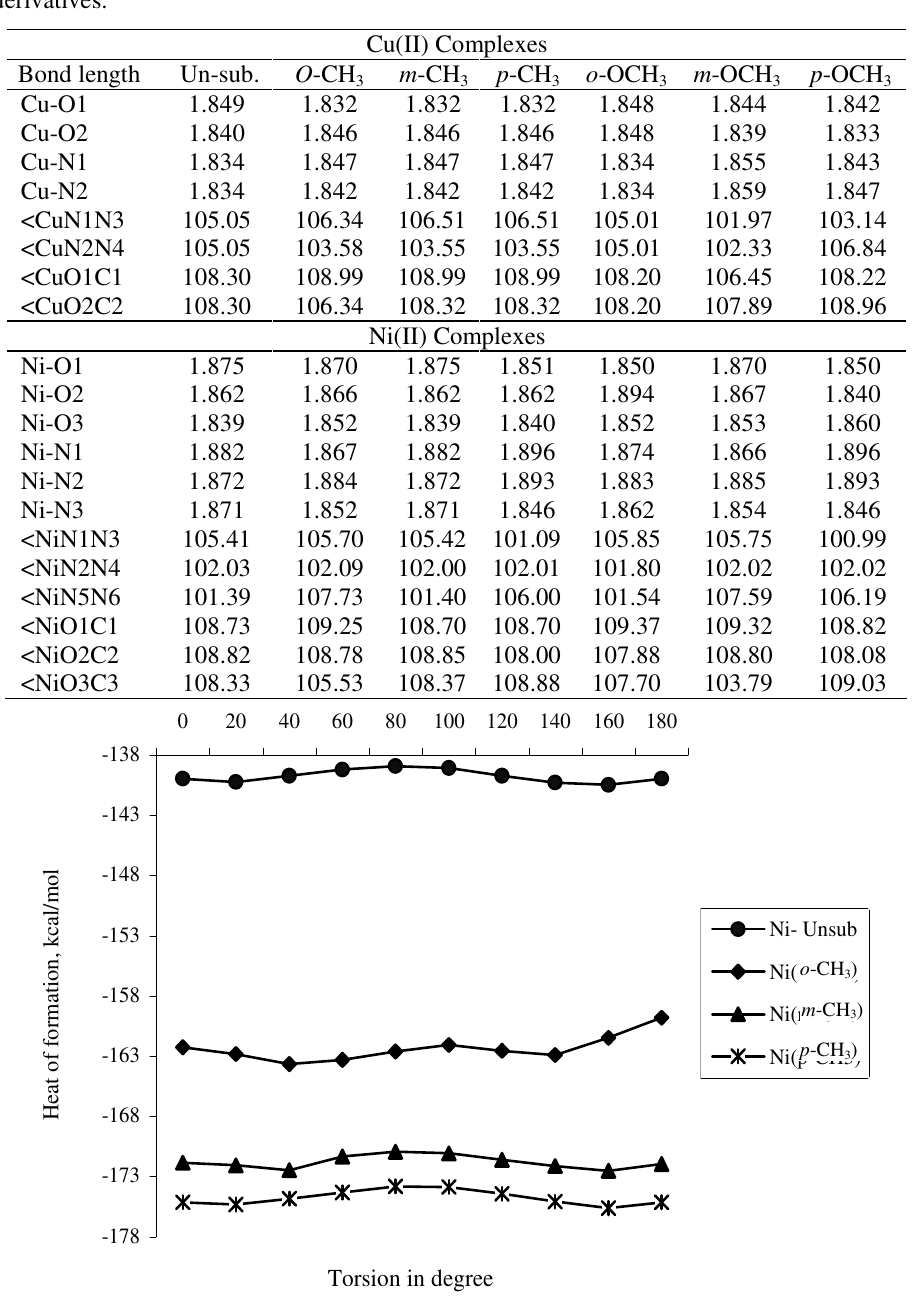
Figure 3. Torsion curves of un-substituted, ortho, meta and para- methyl Ni[C